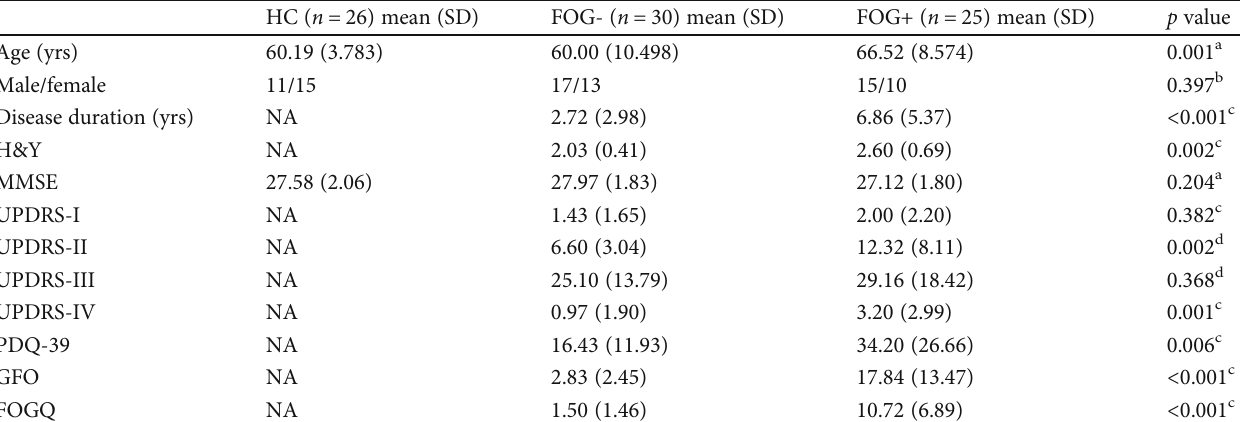
Table 1: Demographic characteristics and clinical